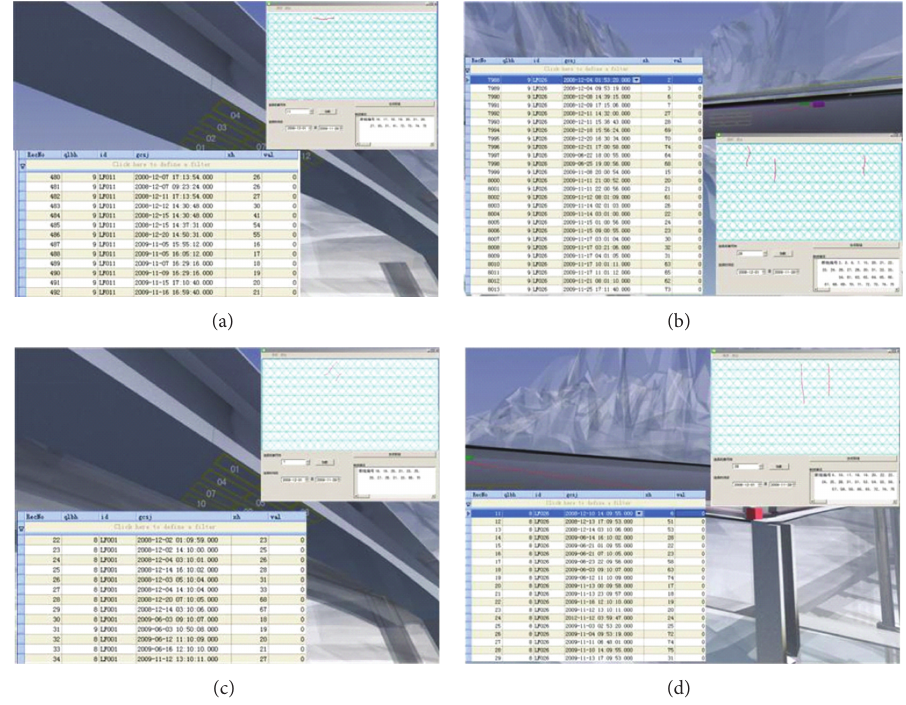
Figure 18: Recurrence of crack on Tukan Wujiang River Bridge.